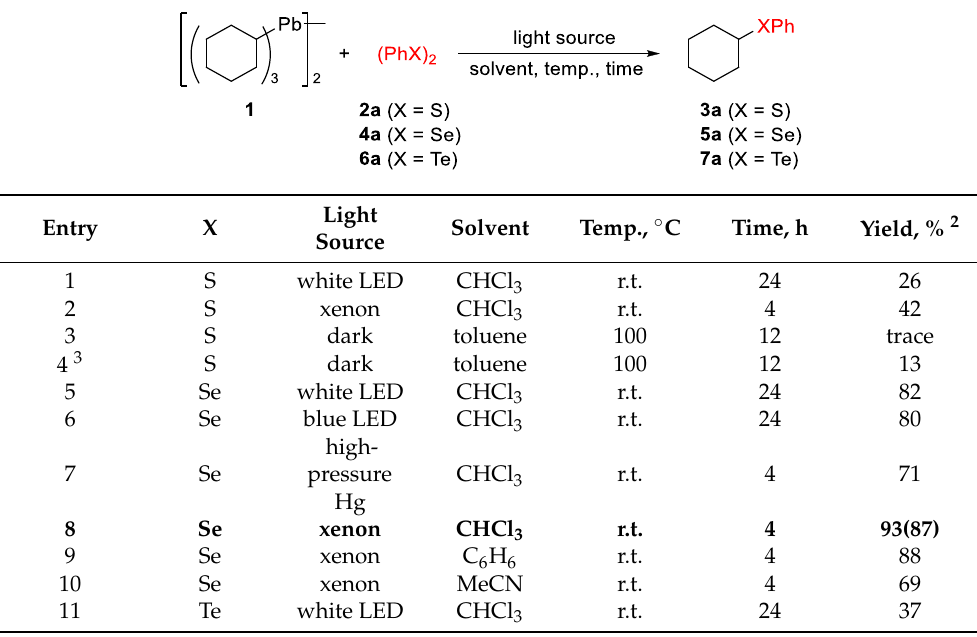
Table 1. Reaction of diphenyl dichalcogenides with hexacyclohexyldilead 1 1 .